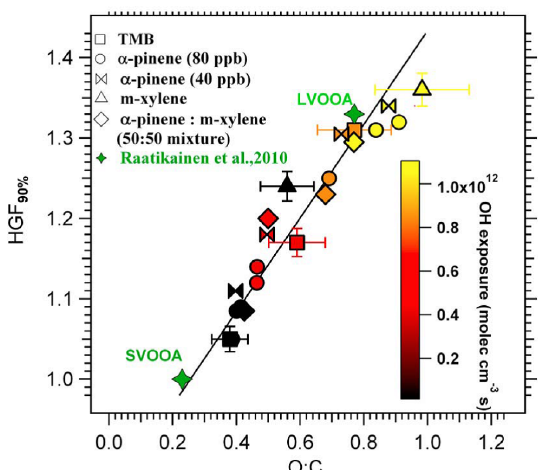
Figure 21. Growth factors of SOA measured using a H-TDMA at 90% RH as a function of O : C ratios. Reprint with permission by Massoli et al. (2010). Copyright 2010 American Geophysical